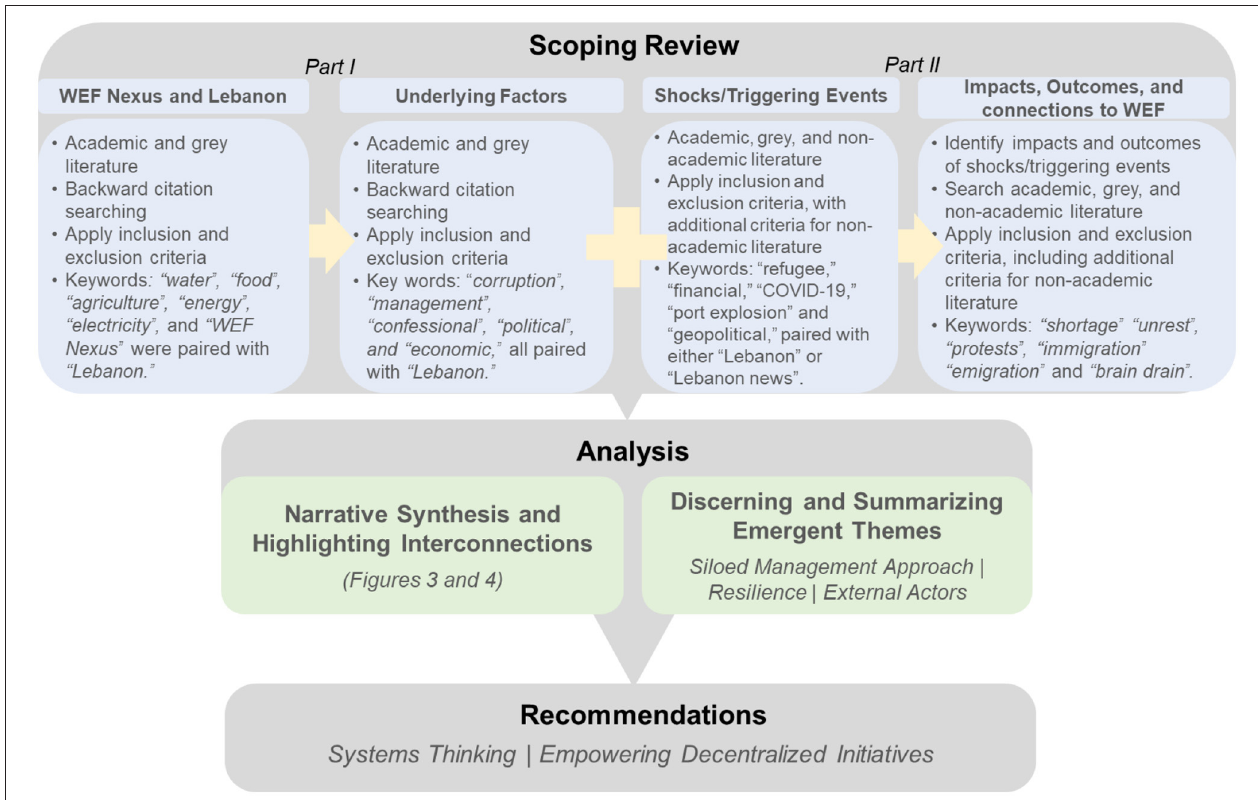
FIGURE 1 | Overarching methodological